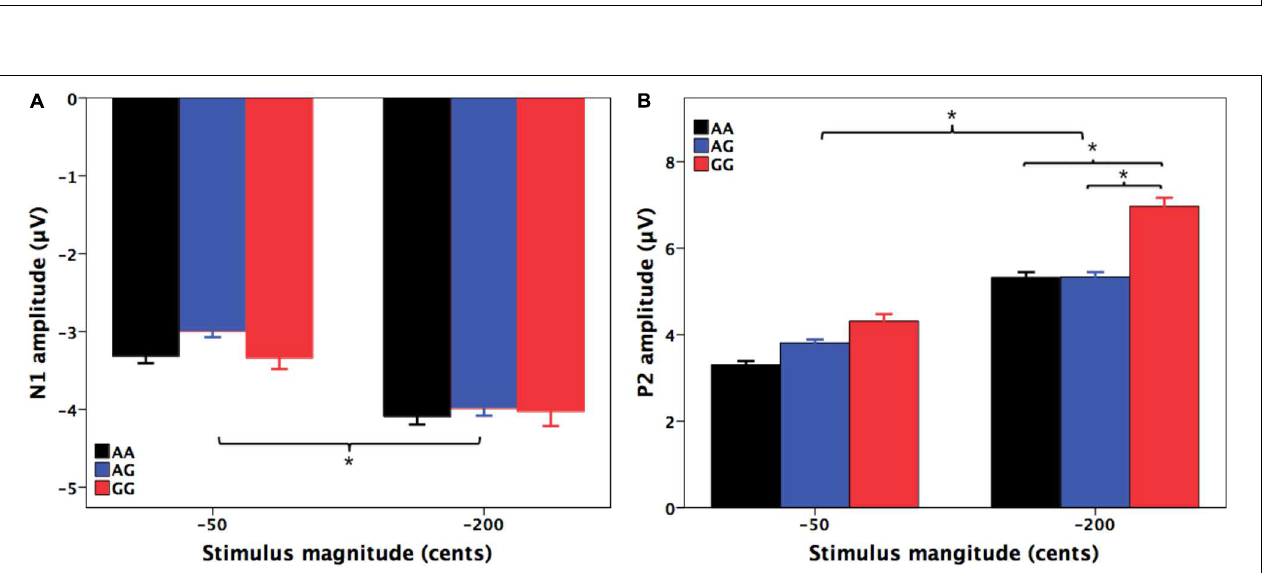
FIGURE 4 | T-bar plots of the amplitudes (mean + SEM) of N1 (A) and P2 (B) responses to –50 and –200 cents perturbations in auditory feedback for the AA (black), AG (blue), and GG (red) genotypes. The –200 cents condition elicited significantly larger N1 ( p < 0.001) and P2 ( p < 0.001) amplitudes than the –50 cents condition. Individuals with the GG genotype produced significantly larger P2 responses to –200 cents pitch perturbations than individuals with the AA ( p = 0.023) and AG genotypes ( p = 0.019). The asterisk indicates significant differences in the N1 and P2 amplitudes across the conditions.